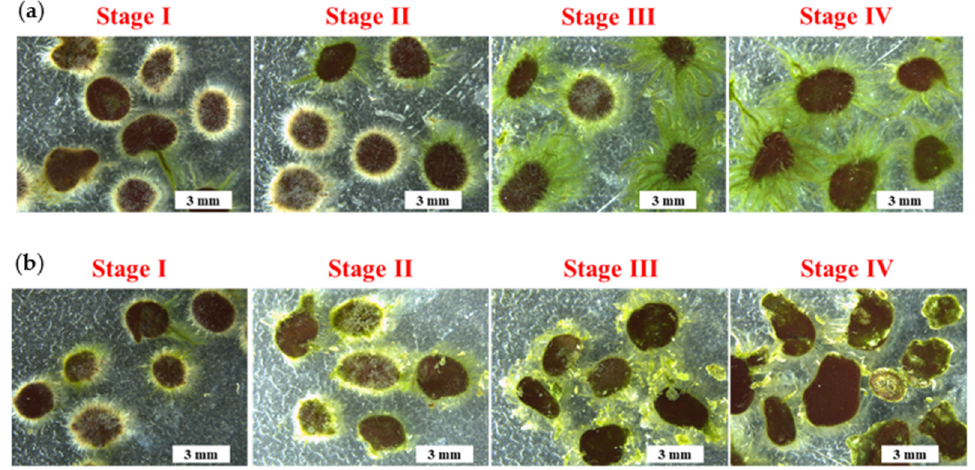
Figure 1. Microscopic images of algal-bacterial AGS from the two reactors during the four stages’ operation. ( a ) R1; ( b ) R2. operation. ( a ) R1; ( b )